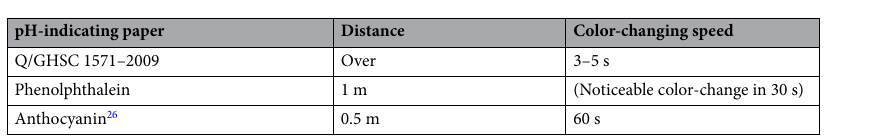
Table 1. Color-changing performances of the color-change RFID tag using Q/GHSC 1571–2009, phenolphthalein and anthocyanin pH-indicating paper.